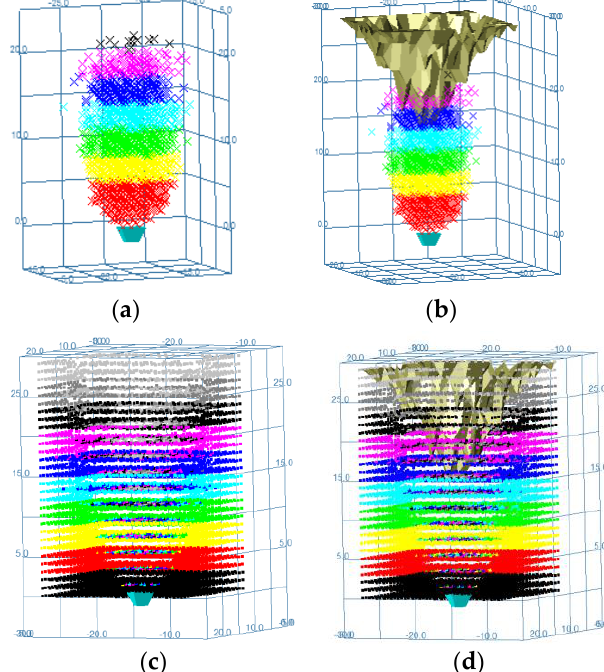
Figure 7. Results of ore draw simulation ( κ = 10%). ( a ) Drawn body; ( b ) Compound diagram of drawn body and ore-rock interface; ( c ) Remnants; ( d ) Compound diagram of remnants and ore-rock interface.